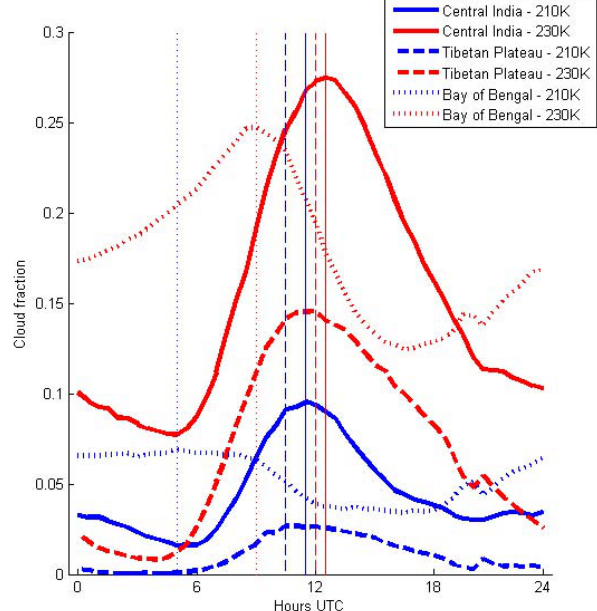
Fig. 10. The comparison of diurnal cycles of convection over the central India, Bay of Bengal and the Tibetan Plateau. The diurnal cycles are derived using Meteosat-5 data for the monsoon seasons of 2002 and 2003. The vertical lines indicate the time of maximum cloud